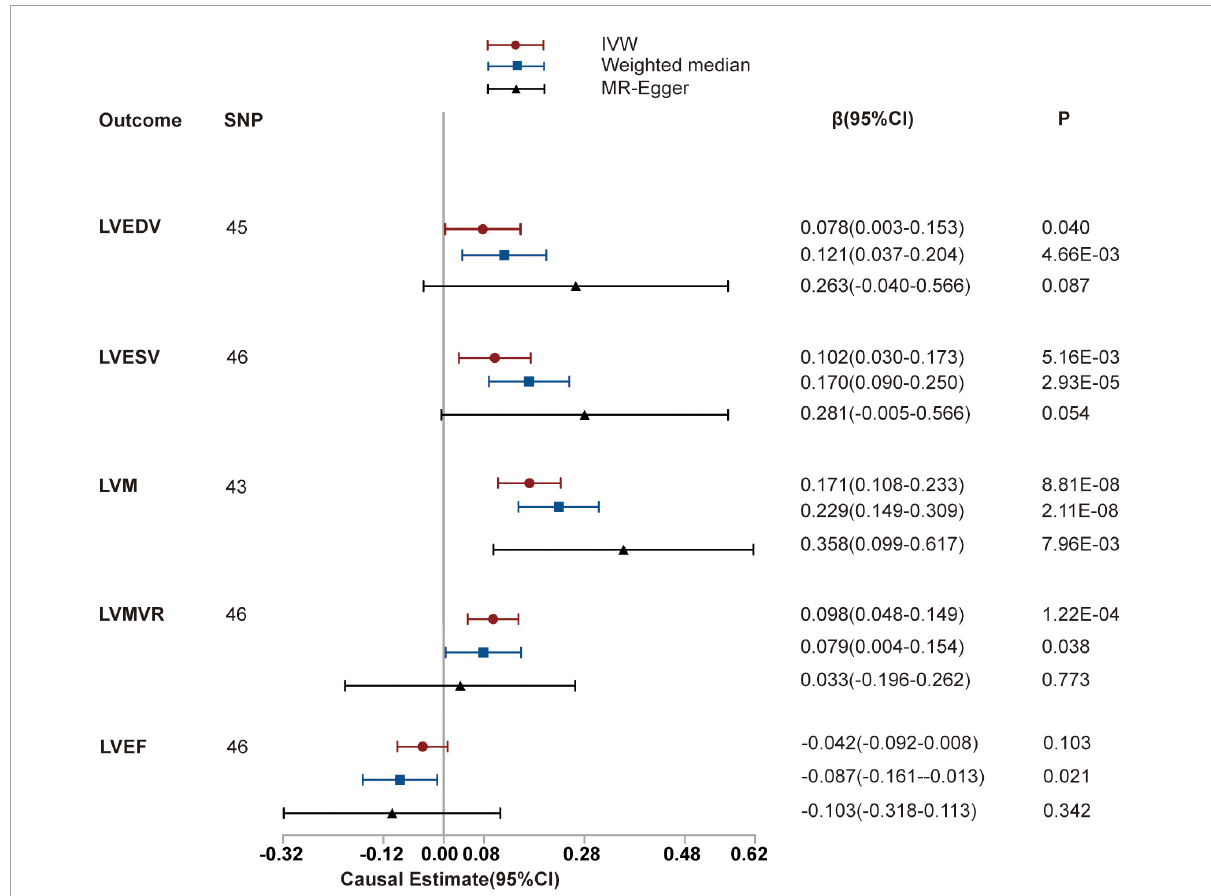
FIGURE3 Mendelian randomization (MR) analyses testing the effect of hypertension on left ventricular index. Results of three MR methods [inverse-variance weighted (IVW), MR-Egger and weighted median] are presented as causal estimates with 95% CIs.